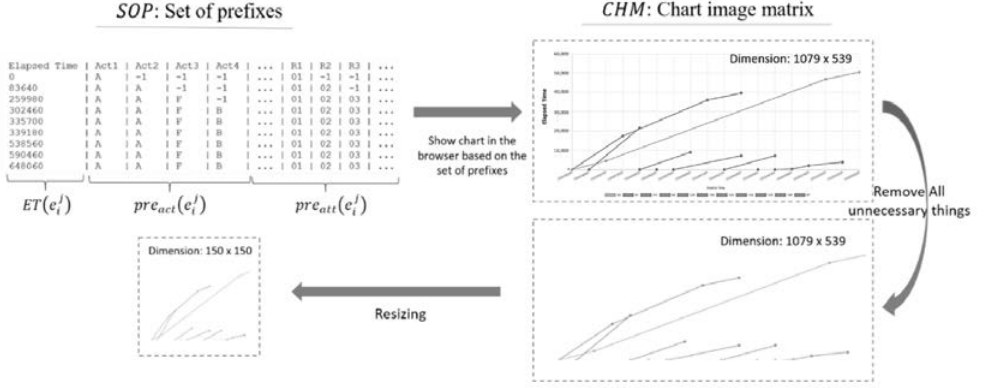
Figure 4. Converting the set of prefixes into a chart image.